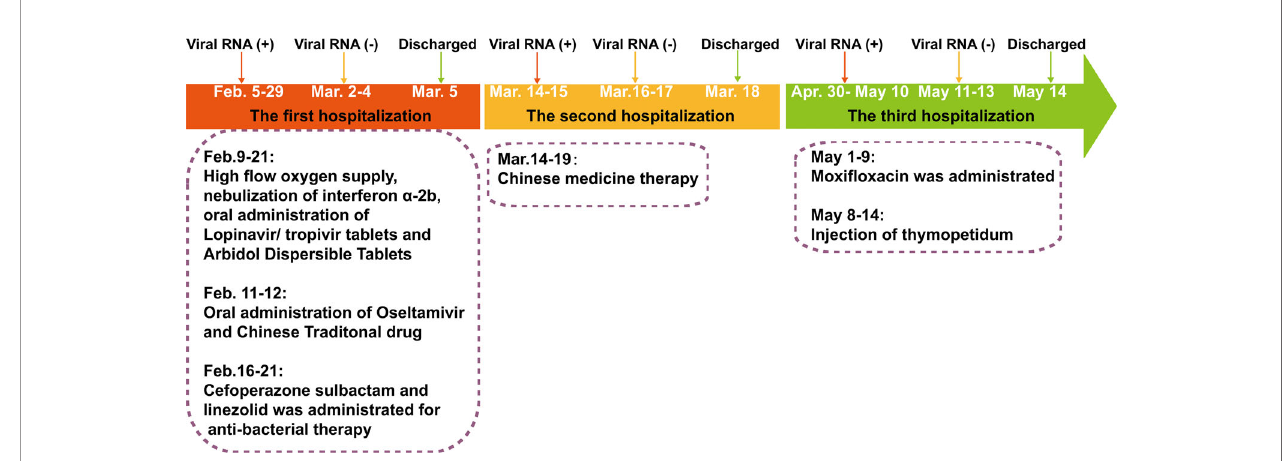
FIGURE 1 | The severe acute respiratory syndrome coronavirus-2 (SARS-CoV-2) reverse transcriptase-PCR test results and clinical therapy of the SARS-CoV-2 RNA re-tested positivity patient during hospitalization